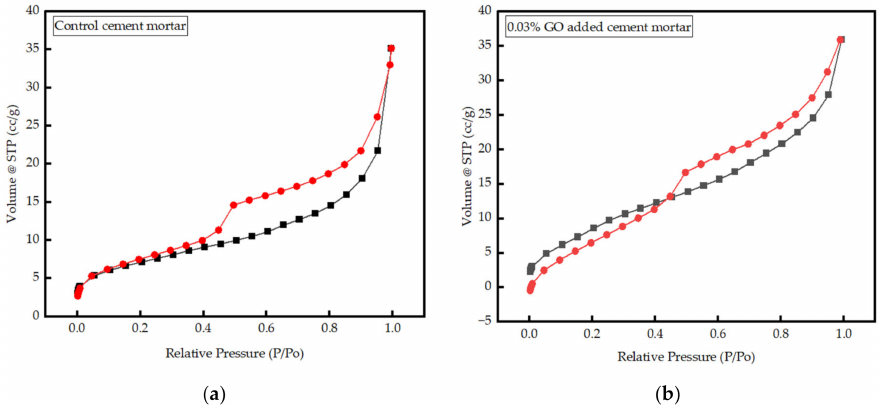
Figure 10. Isotherm graphs for Absorption and Desorption ( a ) control (0% GO) cement mortar; ( b ) cement mortar with 0.03% GO.